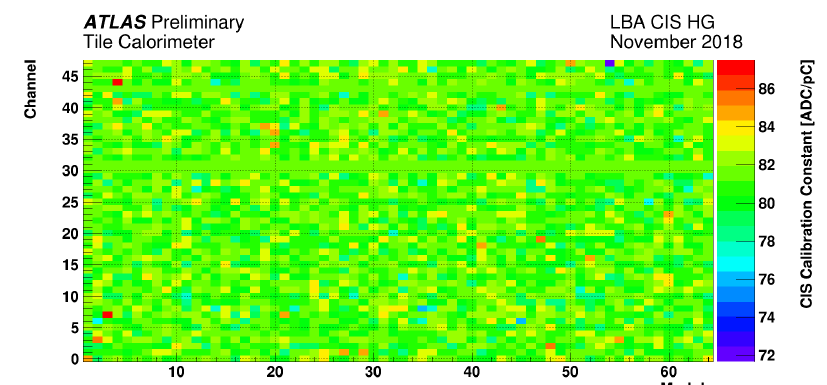
Fig. 5. Charge Injection System calibration constants for LBA modules, UPD4-18 tag. Figure is taken from Ref.